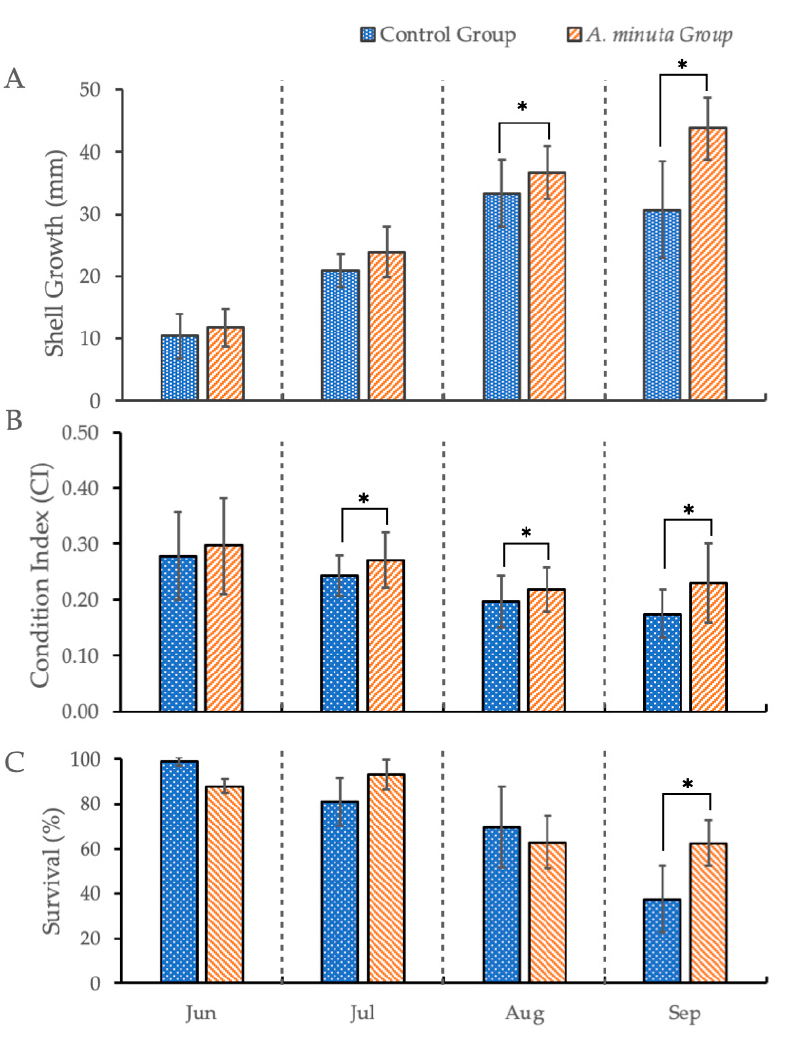
Figure 5. Monthly variation in the ( A ) shell growth, ( B ) condition index, and ( C ) survival rate of oysters per collector (n = 4) during the culture period. Values with “*” are significantly different ( p < 0.05).